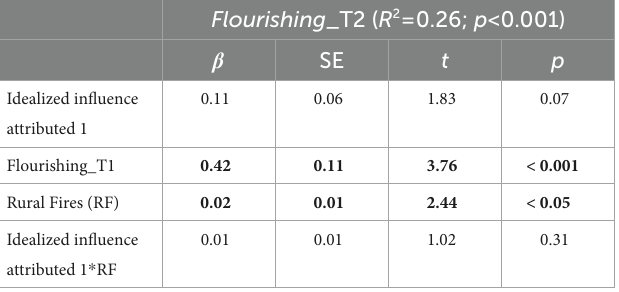
( β = 0.12, p < 0.05). Only in one of the analyses are the values not